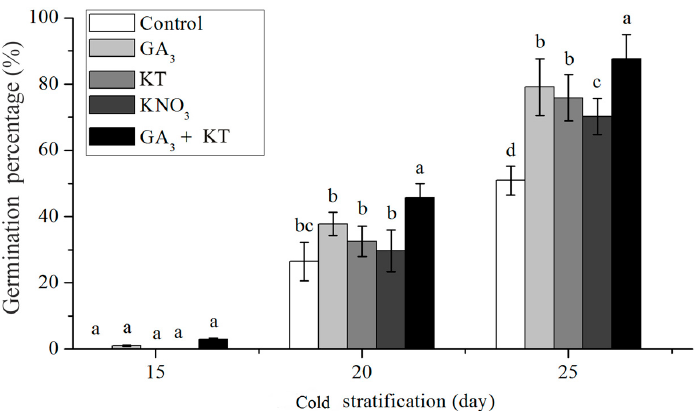
Figure 4. Effect of cold stratification combined with plant growth regulator treatments on the seed germination of Tulipa thianschanica . The different lowercase letters indicate a significant difference at p < 0.05 with Duncan’s multiple range test. Table 4. E ff ect of the duration of stratification on Tulipa thianschanica seed germination at 4 ◦ C with optimal concentrations of plant growth